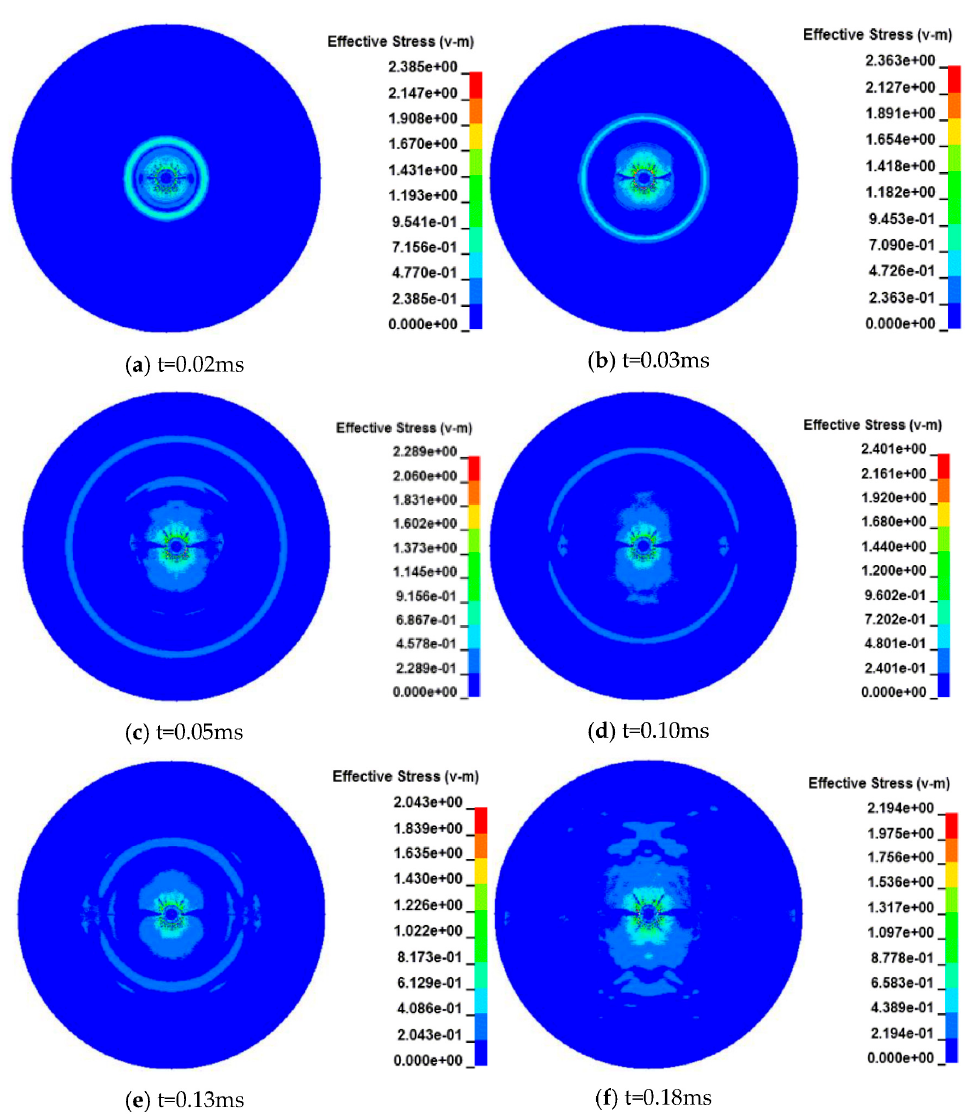
Figure 20. Stress evolution process of single-hole shaped charge blasting.